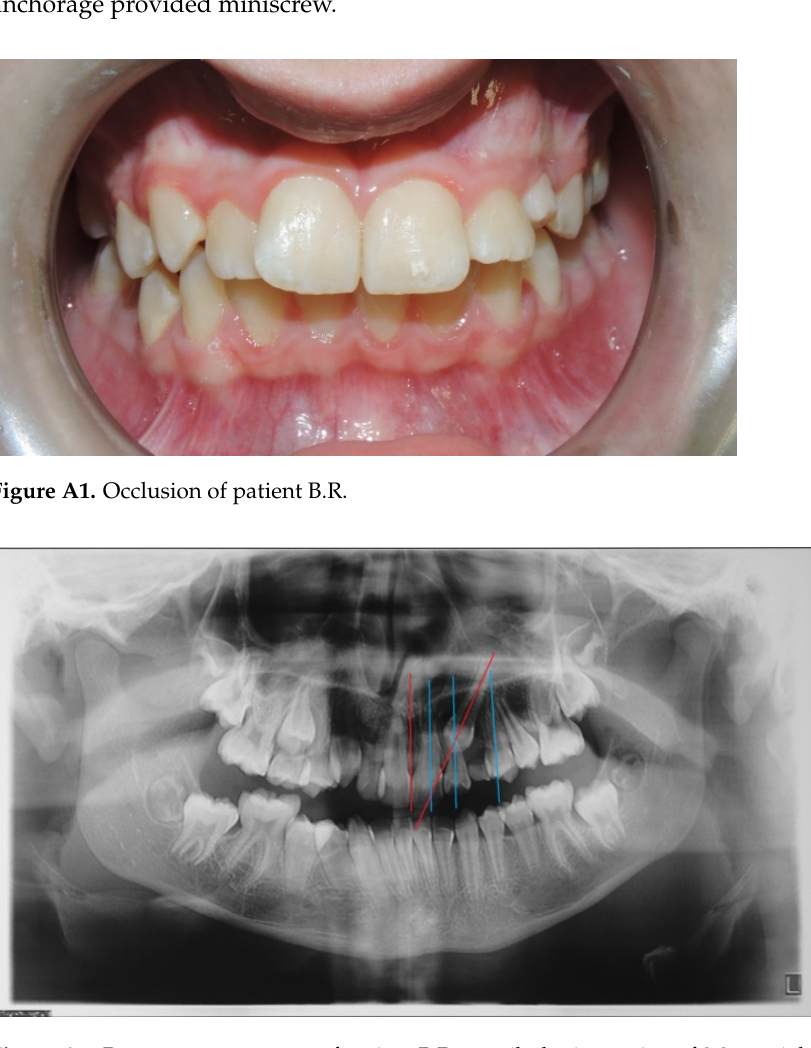
Figure A2. Pretreatment panorex of patient B.R.: vestibular impaction of 2.3, partial superimposition of the canine crown on the lateral incisor root; α angle 26°, sector 3.